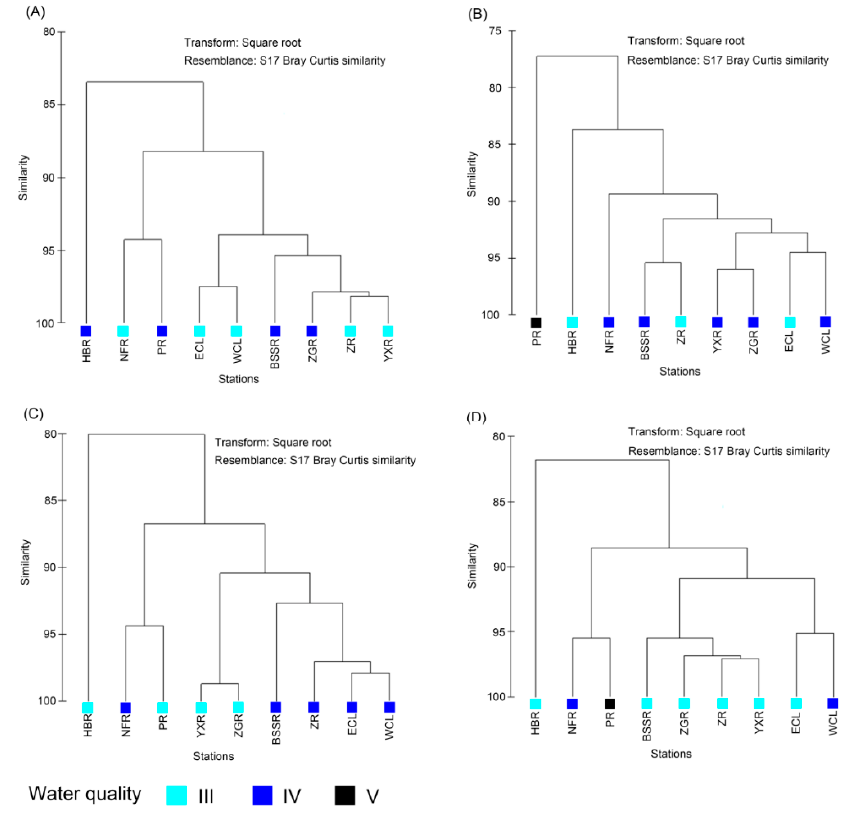
Figure 2. Clustering profiles of physicochemical parameters. ( A ) spring, ( B ) summer, ( C ) autumn, and ( D )